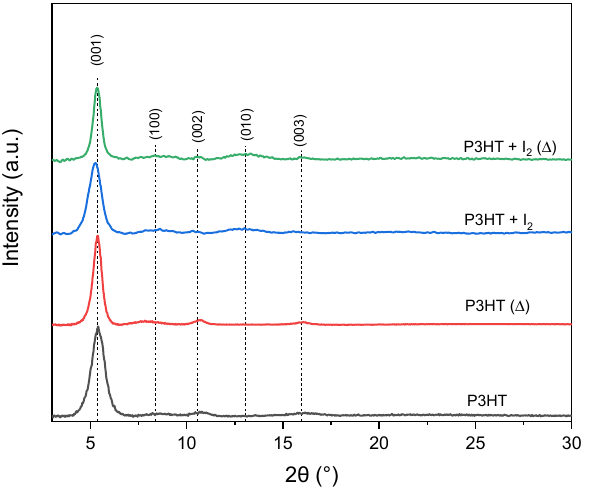
Figure 8. XRD patterns of neat P3HT (P3HT), 10% iodine-doped P3HT (P3HT + I 2 ) before and after ( Δ ) thermal treatment (in 210 °C).